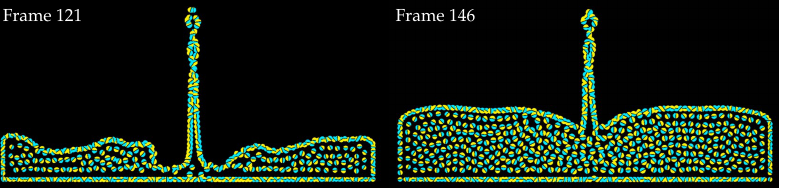
Figure 6. Two-dimensional water particle simulation with our method. The related video has been submitted as Supplementary Material.